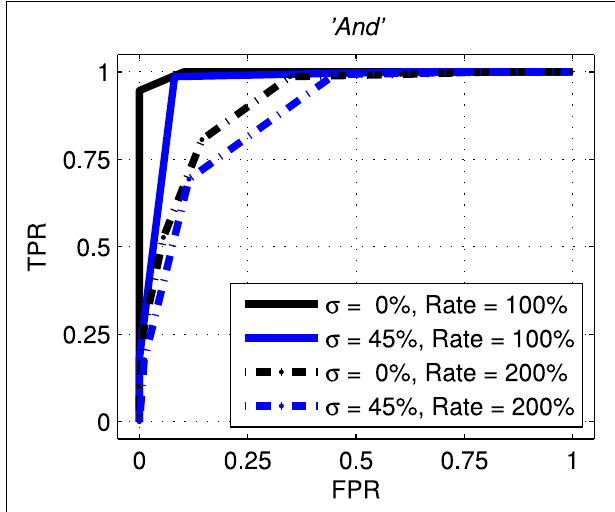
FIGURE 10 | Representative Receiver Operating curves ( ROC ) for the network with exposure stimulus “And.” ROC curves plot the False Positive Rate (FPR or fall-out ) against the True Positive Rate (TPR–sometimes called recall ) for all detection thresholds. For clarity only four conditions are shown with two representing the best and worst case. The solid black line represents the best case with no added noise ( σ = 0 . 00) and with the probe stimuli presented at the normal rate (Rate = 100%). The broken blue line represents the worst case across all conditions with the added noise at 45% ( σ = 0 . 45) and the presentation rate at twice the normal rate (Rate = 200%).